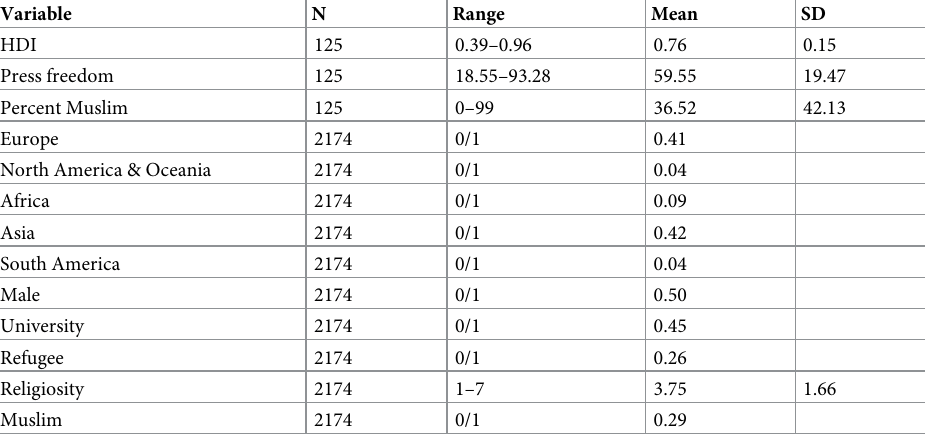
Table 1. Descriptive statistics for country-of-origin and individual variables.